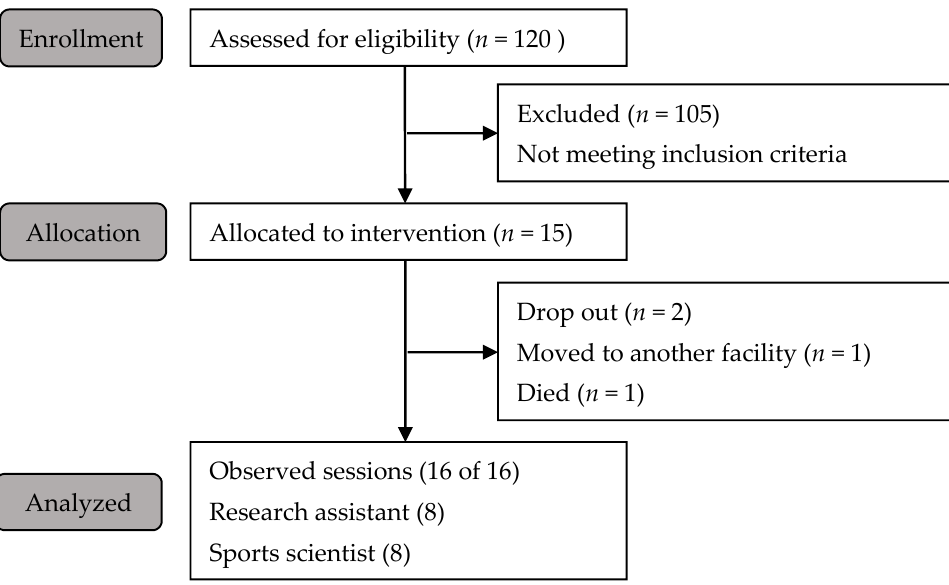
Figure 1. Participant flowchart.